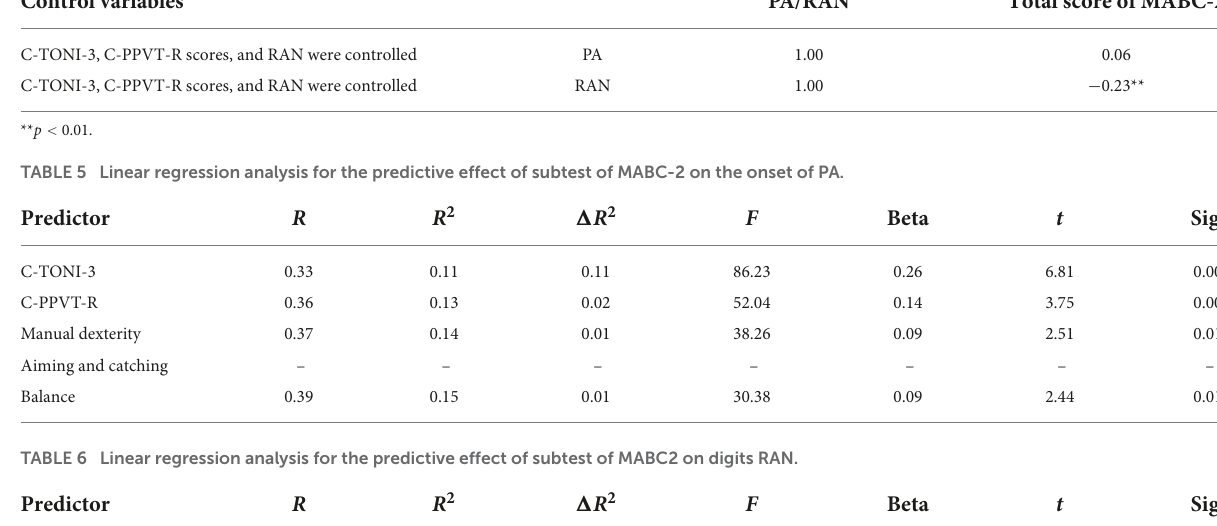
TABLE 4 The partial correlational analysis of PA/RAN and MABC-2 by controlling for C-TONI-3, C-PPVT-R, and RAN/PA. Control variables